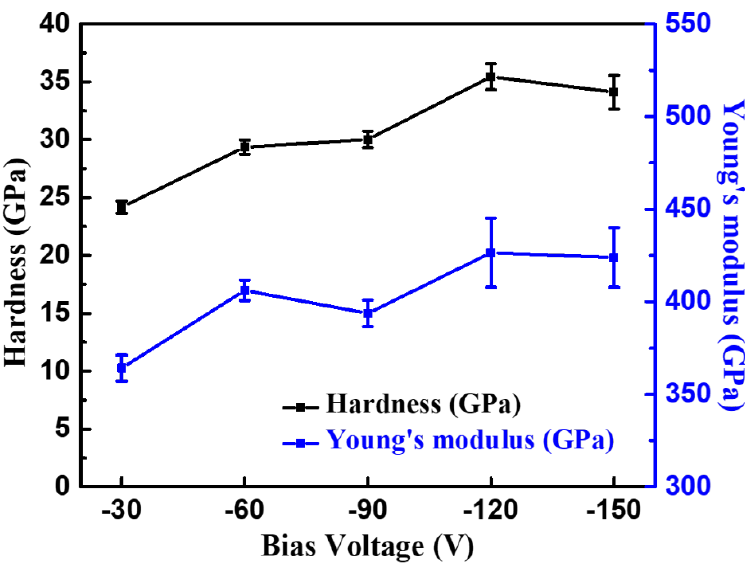
Figure 8. Hardness and Young’s modulus of CrAlN layers deposited under various bias voltages. Table 6. Mechanical properties of CrAlN coatings under various bias